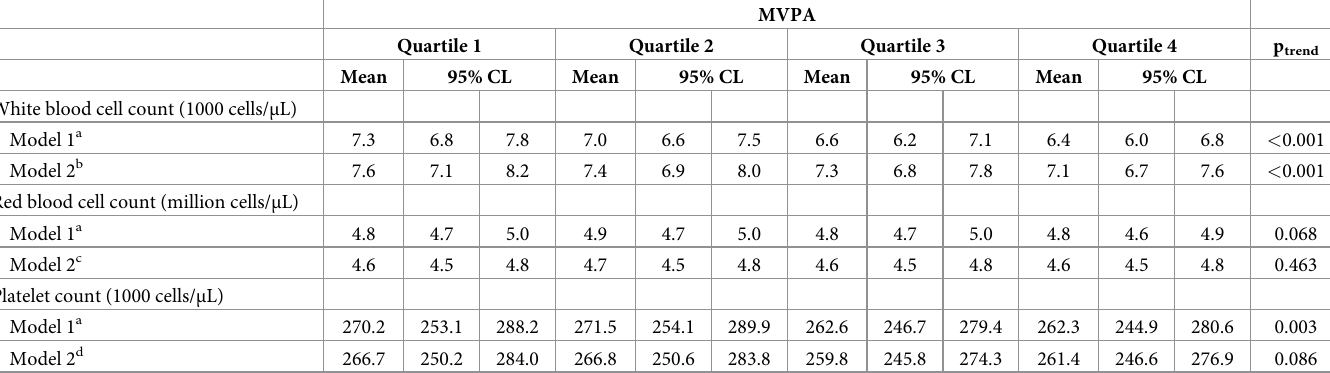
Table 4. Adjusted means (95% CL) for continuous hematologic variables across quartiles of MVPA in U.S. adults (cid:21) 20 years (NHANES 2003–2006). MVPA Quartile 1 Quartile 2 White blood cell count (1000 cells/μL)